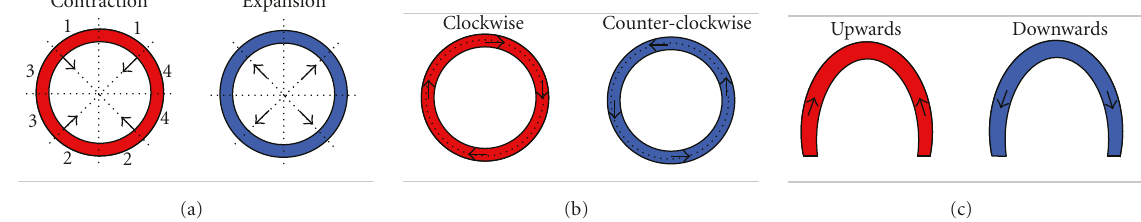
Figure 1: Motion directions defined in the cardiac cycle: (a) radial movement in terms of contraction and expansion; (b) horizontal rotation is either clockwise or counterclockwise; and (c) vertical rotation is upwards or downwards. The two orientations for each direction are colored by the defined coding scheme (see Section 2.1.1). Movements are depicted using the short axis view in (a) and (b) and the horizontal long axis view in (c). The LV walls are depicted in (a) left: region 1 is the anterior wall; region 2 is the inferior wall; region 3 is the septal wall; and region 4 is the lateral wall. (The nomenclatures of cardiac planes and wall segments used in this work follow the recommendations of the American Heart Association, as described in Cerqueira et al. [18].)